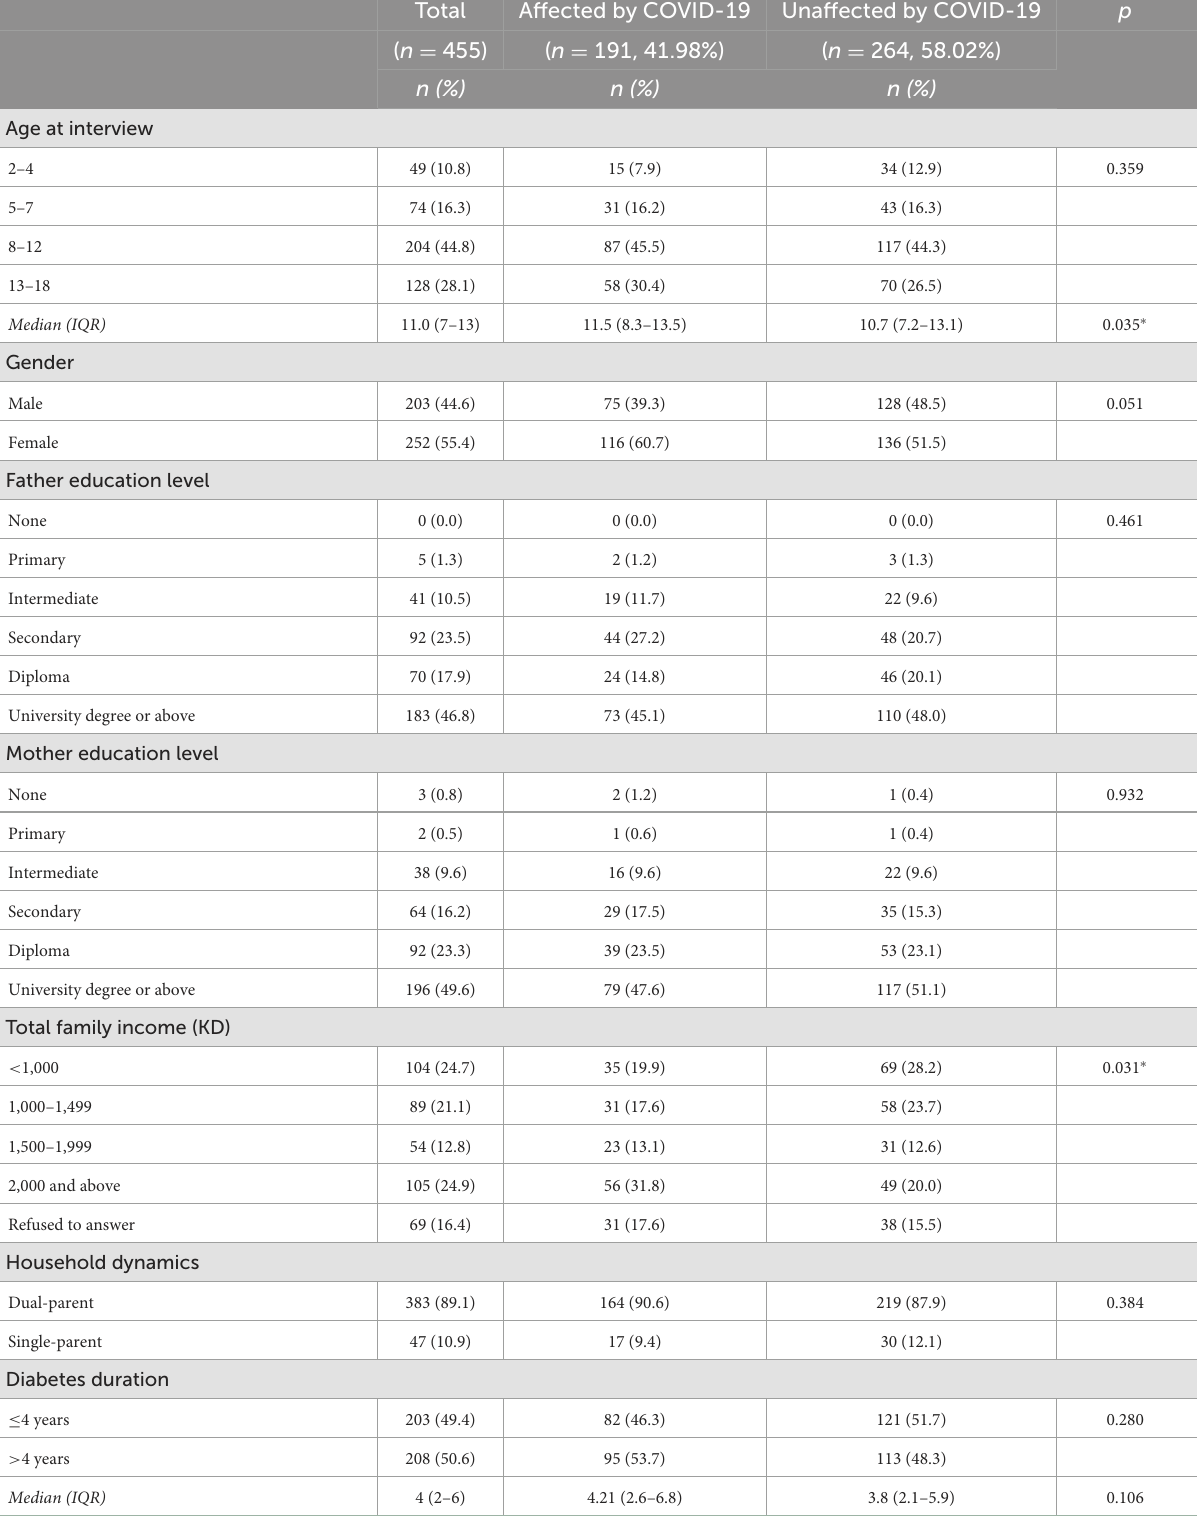
TABLE 1 Baseline characteristics of children with T1D at HRQoL